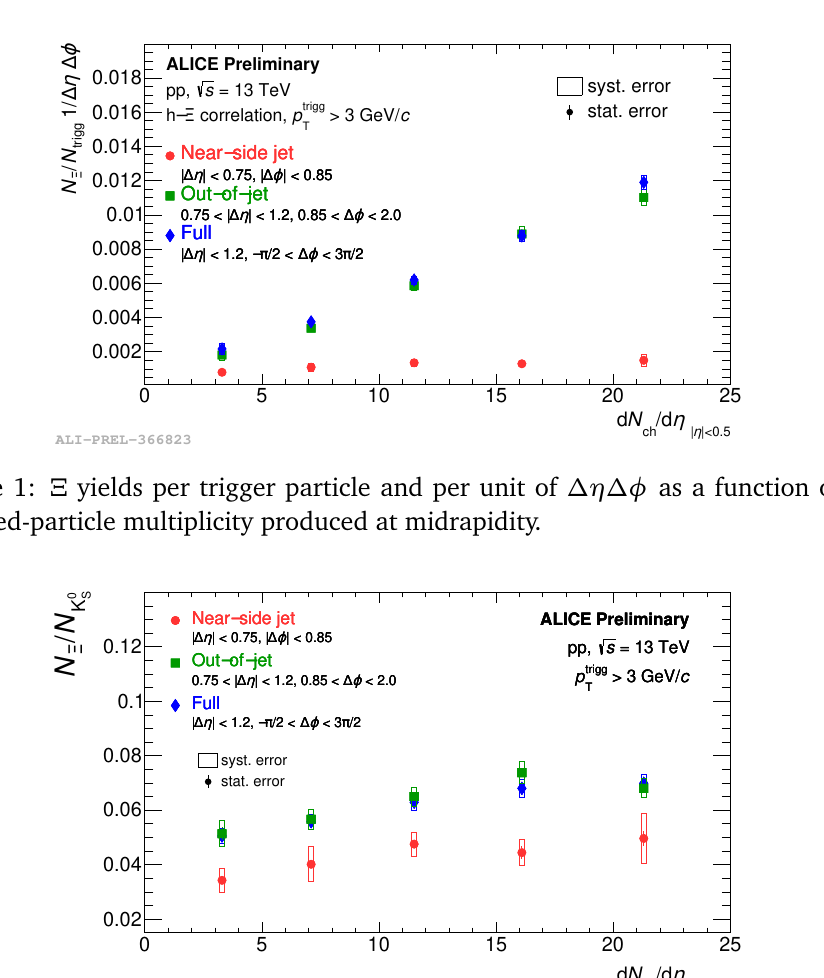
yields as a function of charged particle multiplicity S